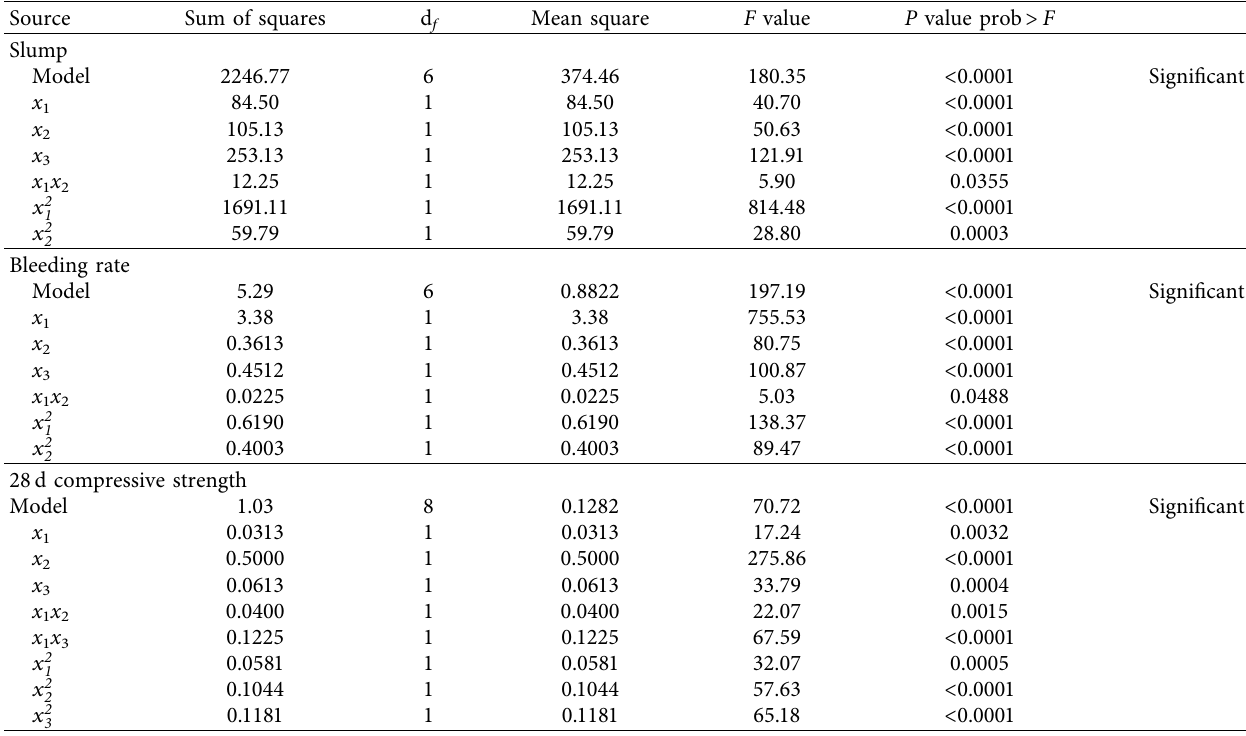
Table 6: Results of ANOVA.